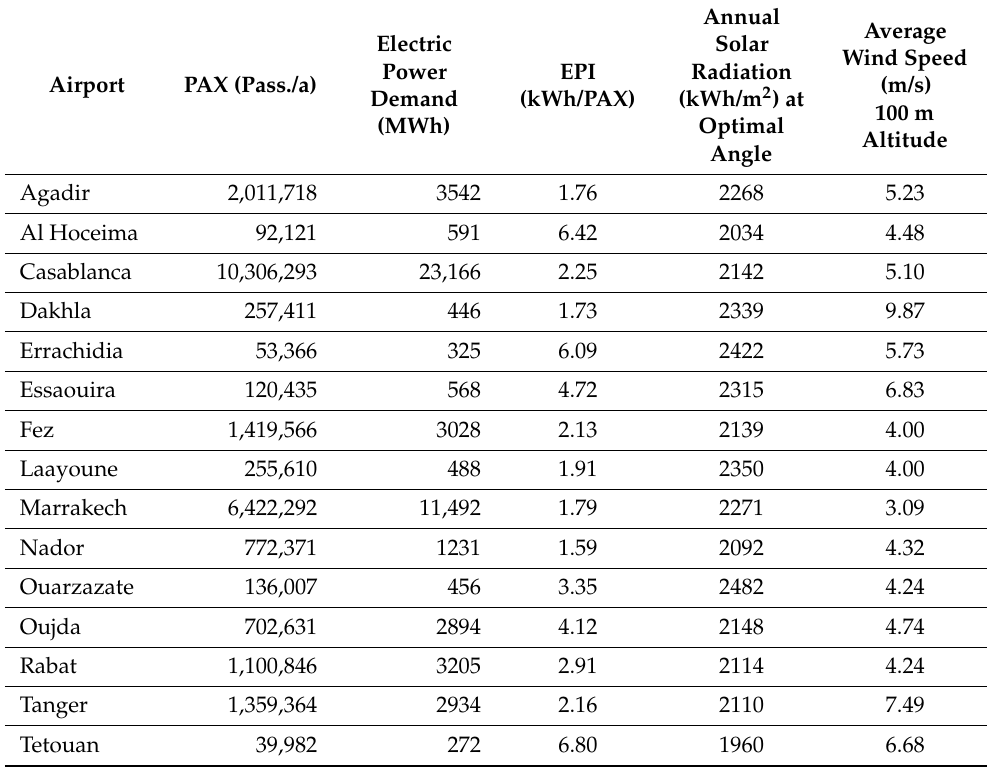
Table 1. Statistical data on selected airports in Morocco. Solar radiation and wind speed measurement originate from the World Bank Group Solar Atlas [6] and World Bank Group Wind Atlas [46]. Airport PAX (Pass./a)